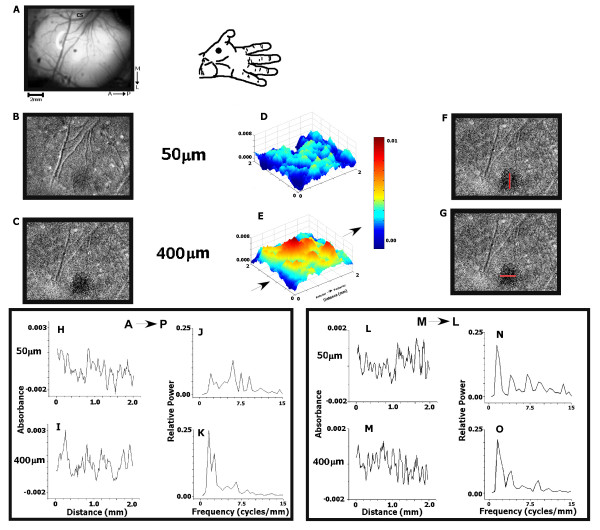
Comparison of SI cortical responses evoked by low- and high-amplitude 25 Hz flutter stimuli. A: View of the somatosensory cortex with the lateral end of the central sulcus (CS) at the top. Stimulus location is shown on the hand figurine. B: Optical response of the SI to the low-amplitude (50 μm peak-to-peak) flutter. Shown is the light absorbance image ([poststimulus image – prestimulus image]/prestimulus image) averaged across 20 stimulus trials, and in each trial across 3 poststimulus images taken during the 5–7 sec interval of continuous stimulation. Increased light absorbance is indicated by darker shading. C: Optical response of SI to the high-amplitude (400 μm) flutter. D & E: Magnified 3-D surface maps of OIS magnitude in the responding cortical region. F & G: Orientation of segmentation in the M-L dimension (F) and the A-P dimension (G). H, I, L & M: Spatiointensive histograms generated via segmentation of areas indicated in F & G for two different stimulus conditions. J, K, N & O: Periodograms showing the spatial frequency composition of the spatiointensive histograms. Note change in the power spectra with the change in stimulus amplitude in data sampled in the A-P orientation, but not in the M-L orientation.